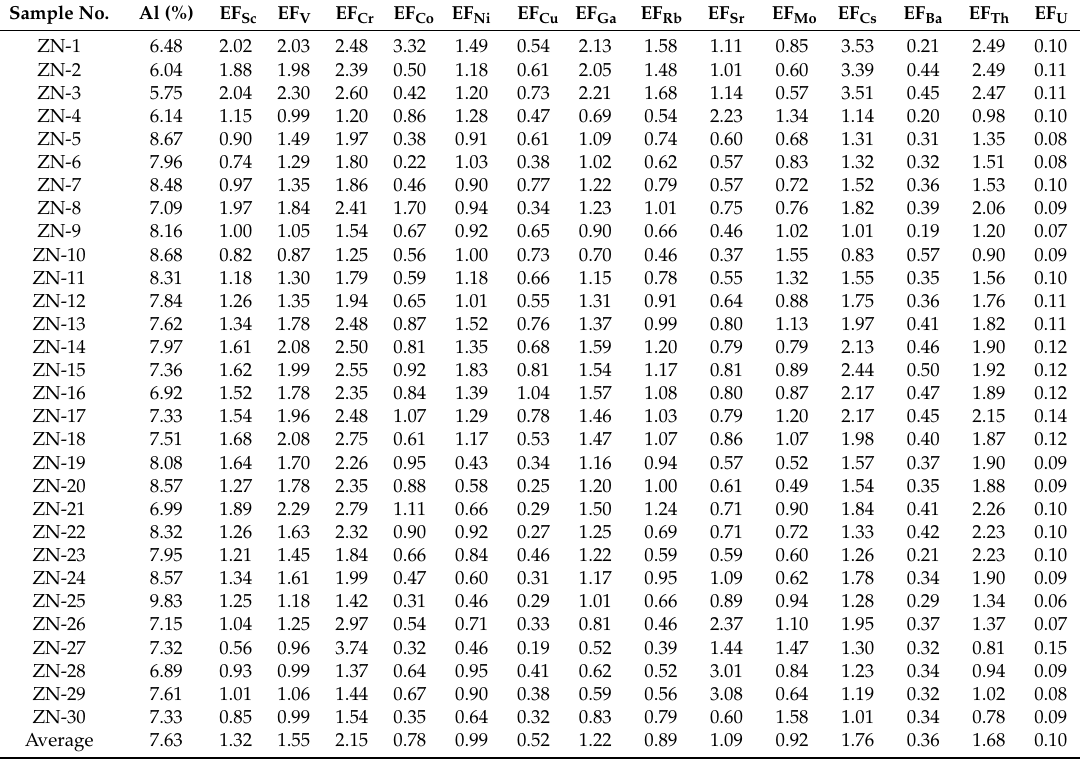
Table 3. Enrichment Factors (EFs) for the selected trace elements from the studied section. Sample